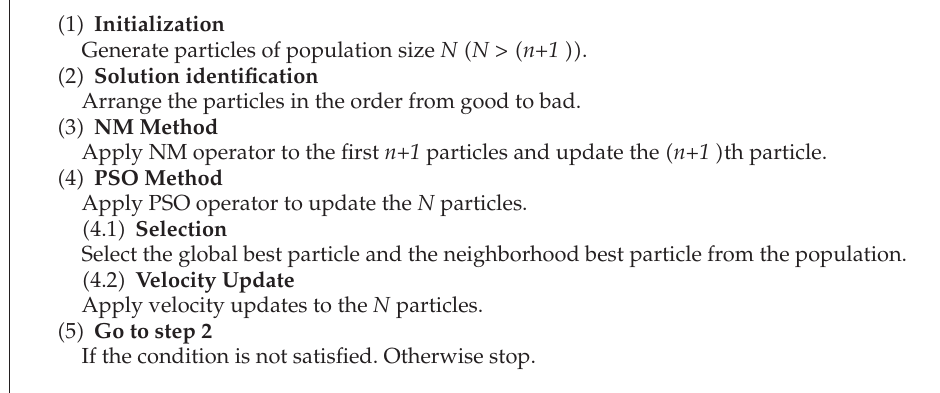
P SEUDOCODE 1: Pseudo Codes of the proposed M-NM-PSO